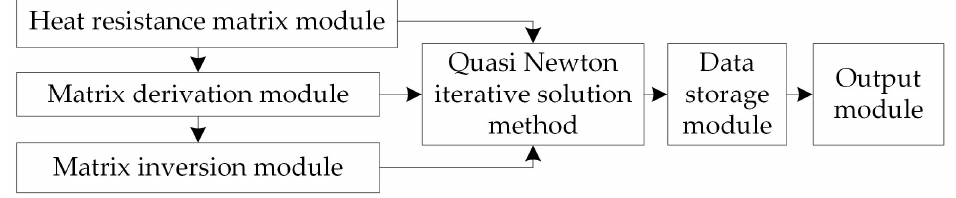
Figure 4. Module relationships in MATLAB.